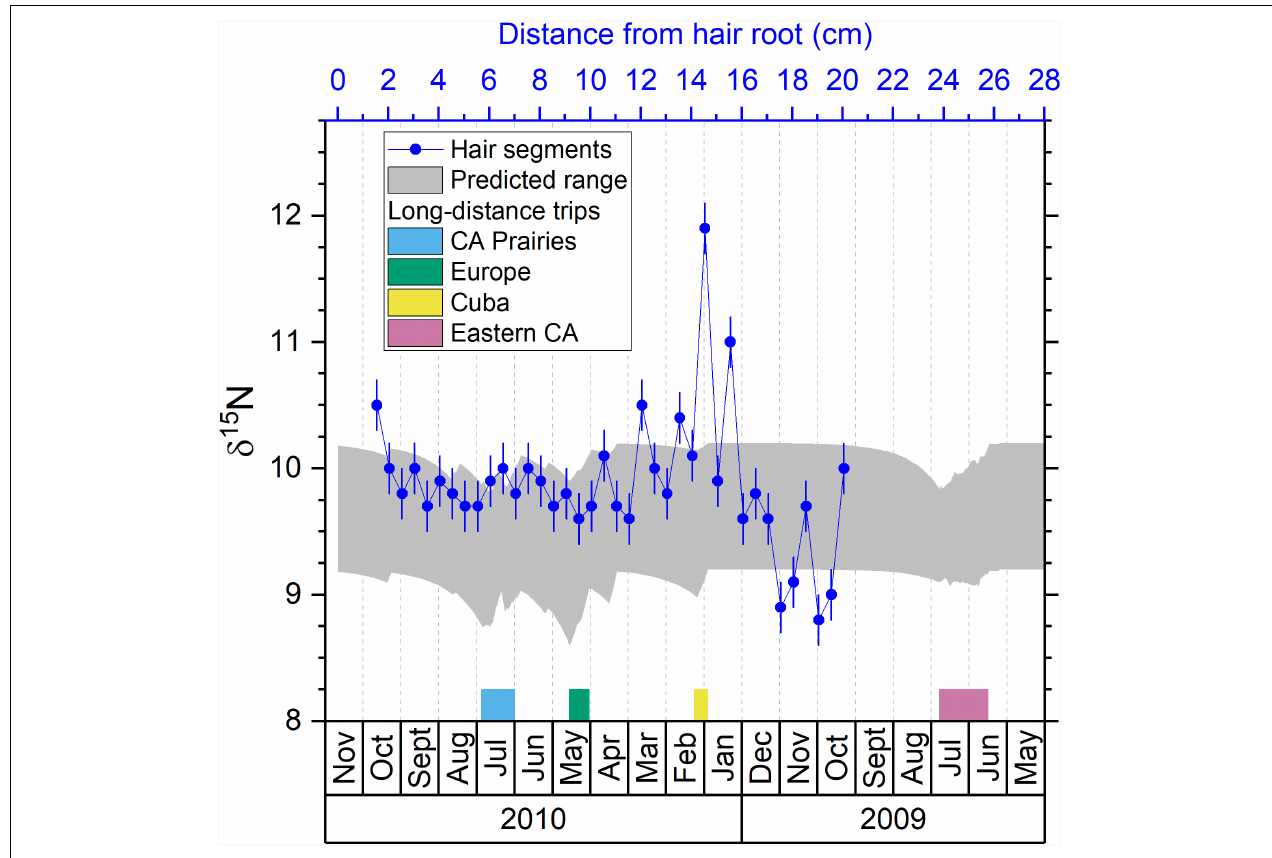
FIGURE 4 | Comparison between the predicted isotopic profile and the measured isotopic values in hair segments for nitrogen. Blue dots are the measured δ 15 N values in hair segments versus their distances from the hair root (top axis) . The shaded area is the predicted range of δ 15 N values in hair versus the date (bottom axis) . The periods of the four major trips are marked with colored bars next to the bottom